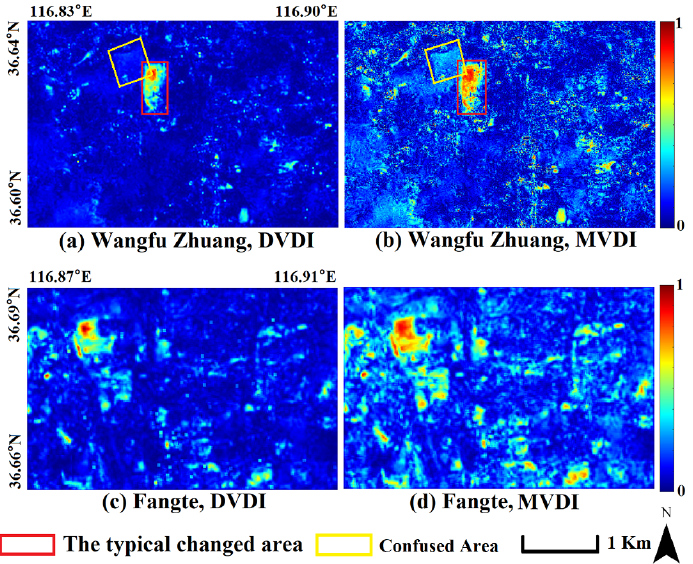
Figure 6. Single difference images: ( a ) DVDI and ( b ) MVDI around Wangfu Zhuang Station and ( c ) DVDI and ( d ) MVDI around Fangte Station. Note: these images were derived from SAR images captured during the period between 22 January 2019 and 5 January 2020.